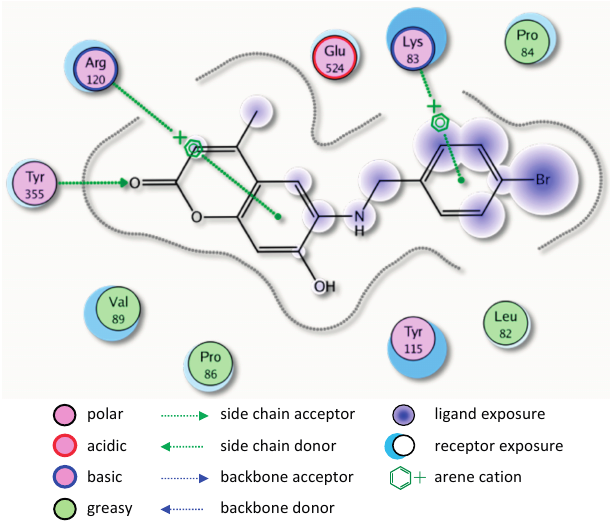
Figure 4. 2D representation of docking of compound 5 into the COX-2 active site. The binding of compounds 8 and 10 is shown in Figures 5 and 6, respectively.